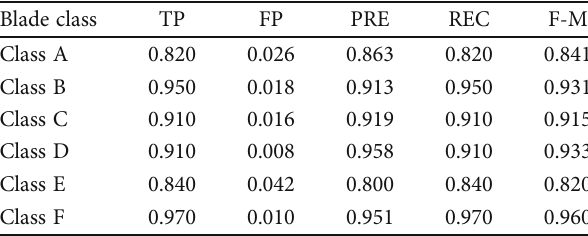
Table 6: Class-wise accuracy of LAD tree.